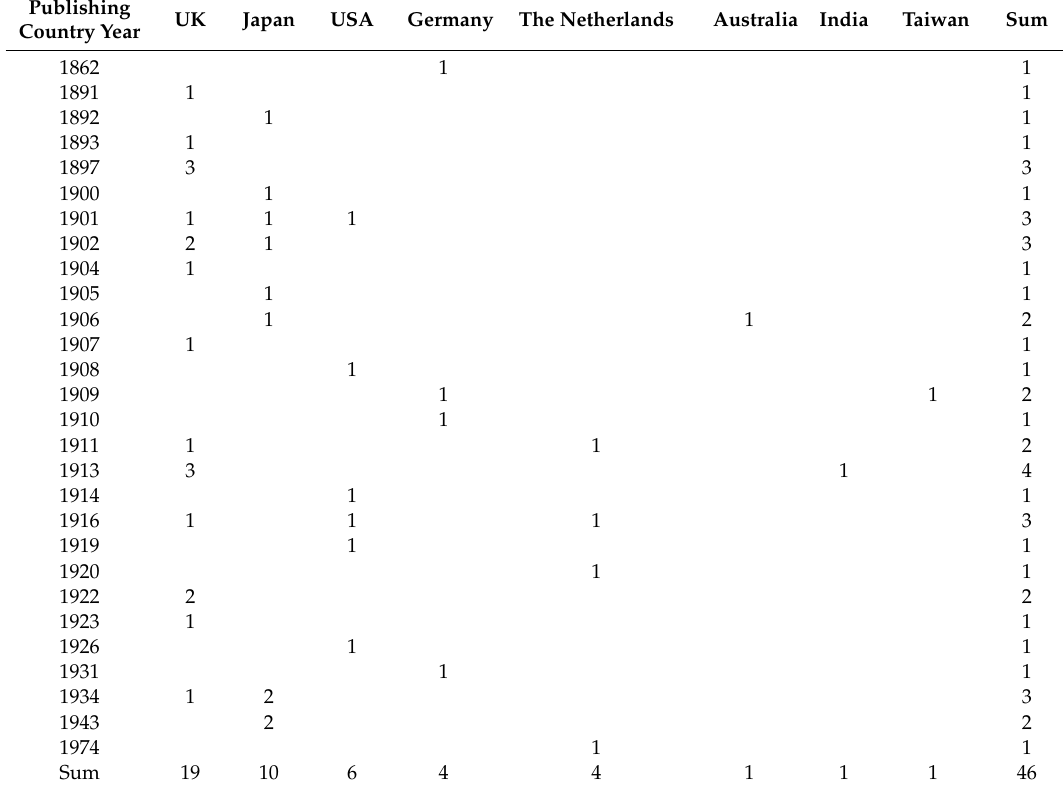
Table 1. Year and country of publication of the damaged old books in this study. Publishing Country